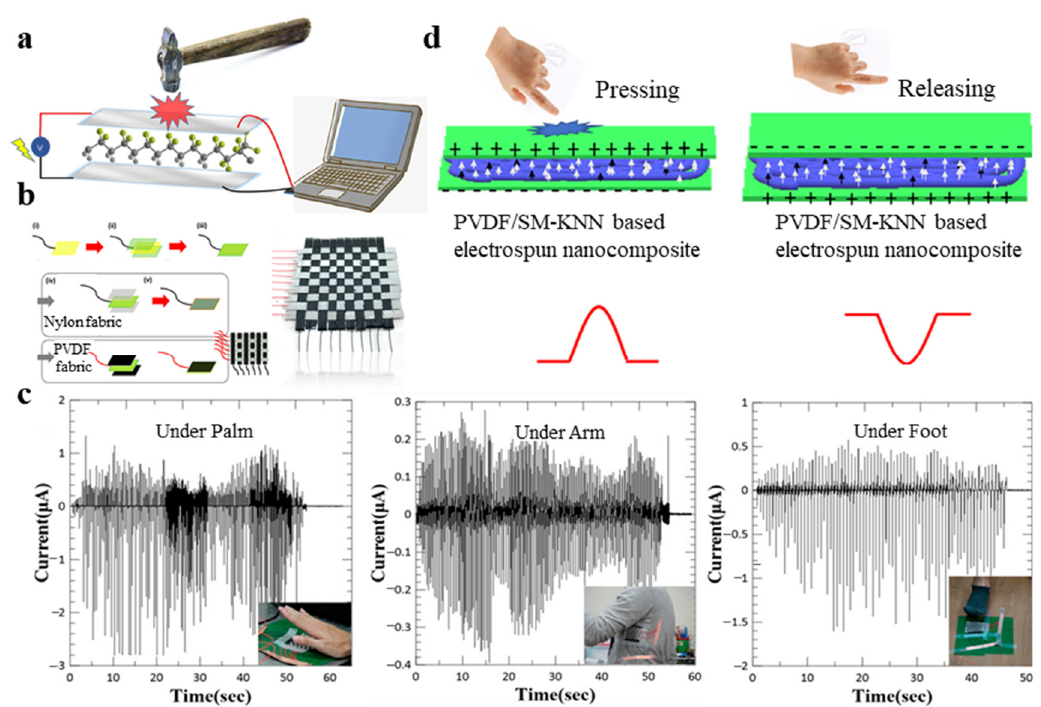
Figure 10. ( a ) Schematic of the energy harvesting device; ( b ) schematic diagram of woven nanogenerator production process [140]; ( c ) nanogenerator harvests energy from human finger tapping, human arm movement and human footsteps [140]; and ( d ) the phenomenon of charge separation during the process of press nanogenerator and release pressure of nanogenerator [141]. In 2020, Mokhtari et al. [142] fabricated a high-performance hybrid piezofiber composed of a PVDF and barium titanate (BT) nanoparticle (mass ratio 10:1). These fibers are knitted to fabricate a